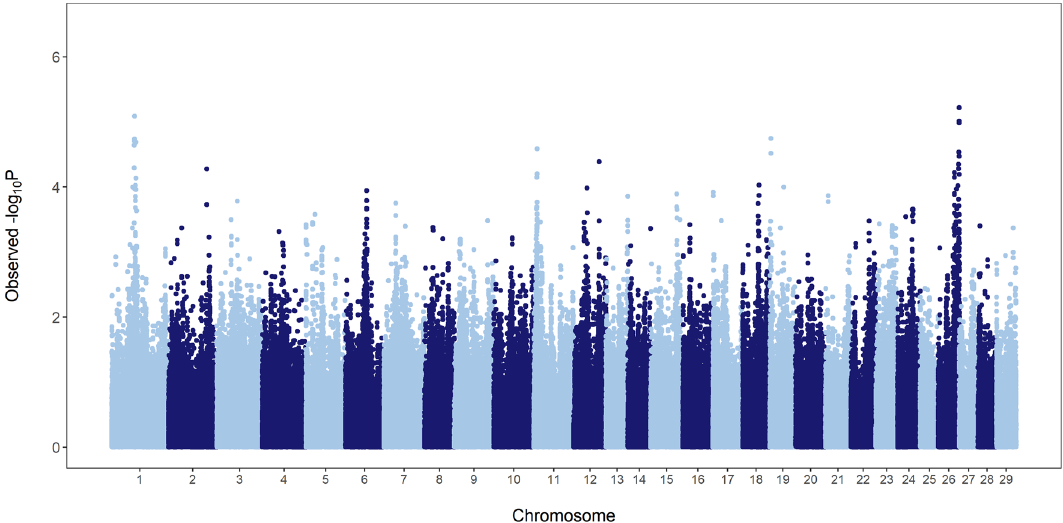
Figure 1. Manhattan plot showing the significance of additive effects on sire conception rate in Brown Swiss